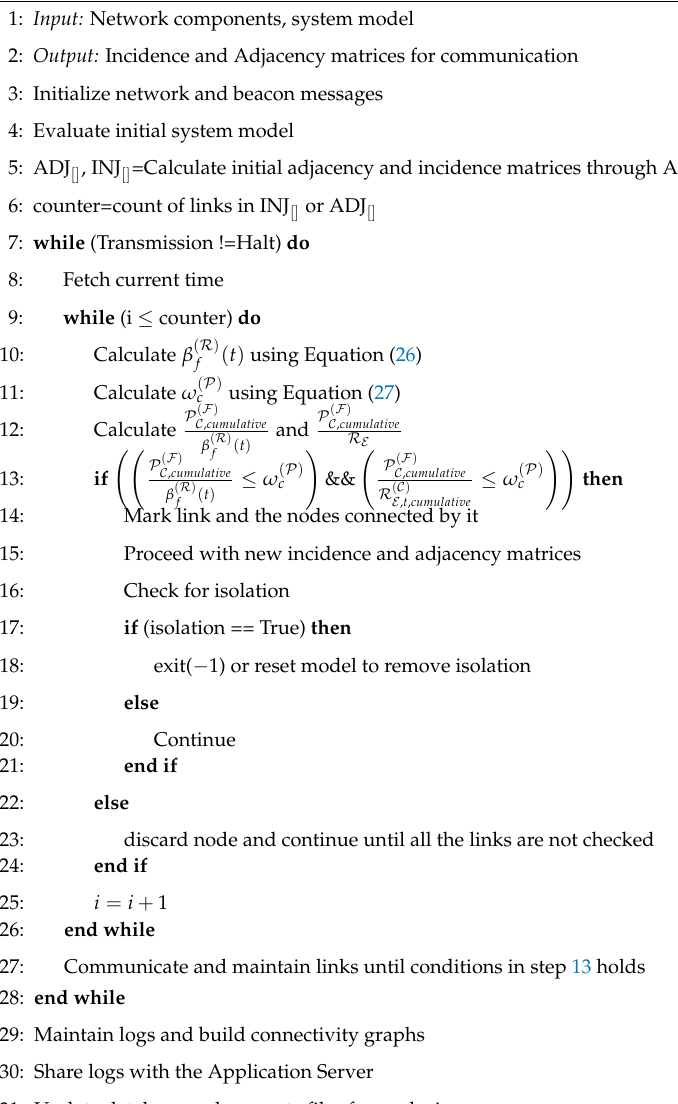
Algorithm 3 LoRaWAN-based Drone Communications for